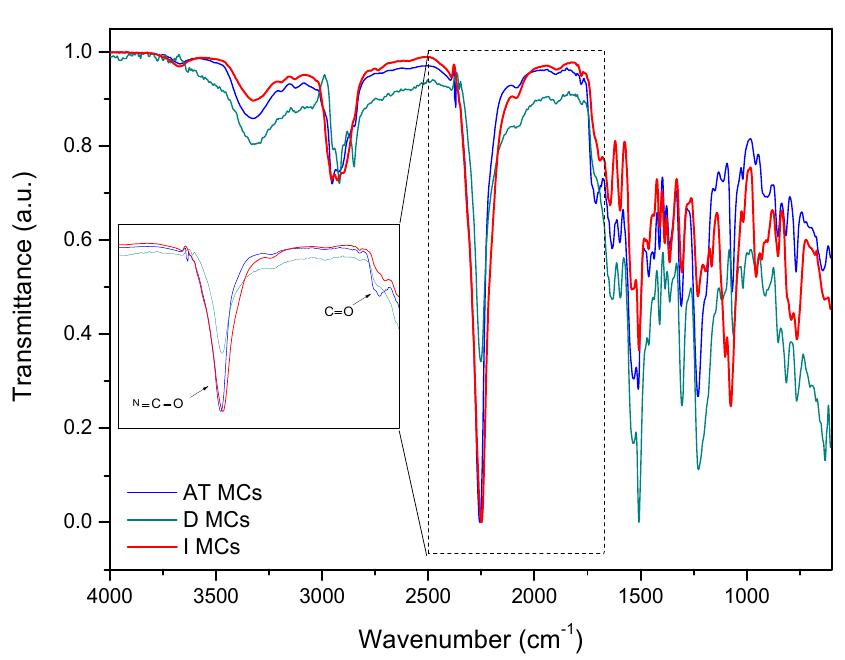
Figure 9. FTIR spectra of MCs obtained in this work. The inset shows a magnification of the peaks assigned to isocyanate NCO bond stretching and to the carbonyl (C=O) group present in urea and urethane moieties.